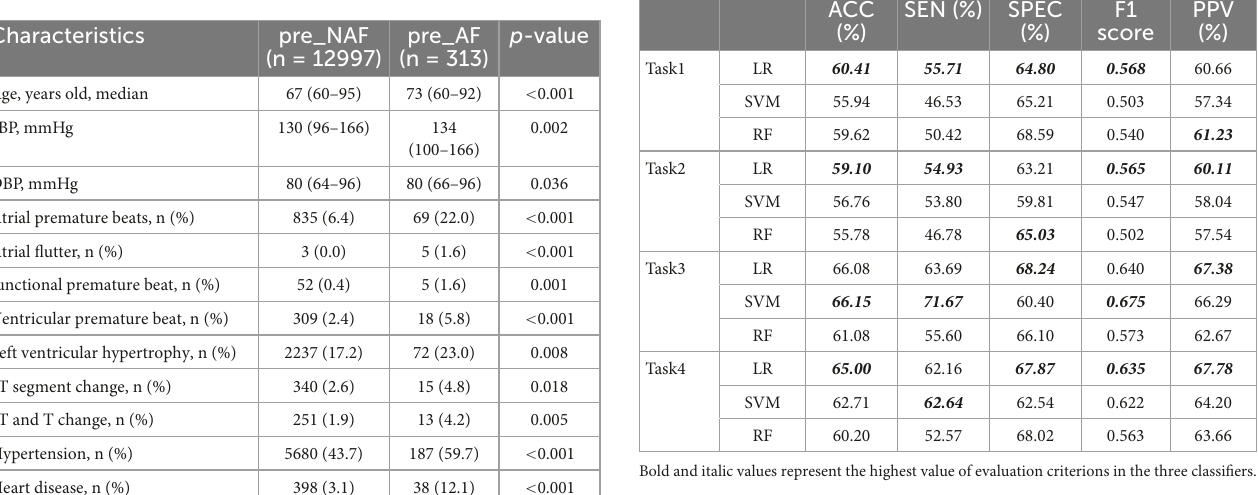
TABLE 7 The results of three machine learning models used for all baseline characteristics in 4 tasks.